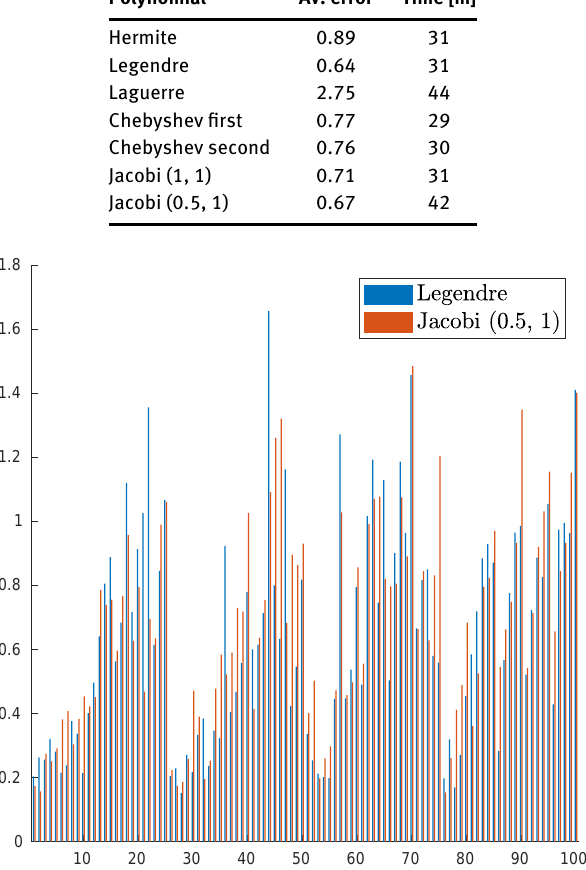
Figure 4: Empirical error for every test of the 3D grid of parameteri-